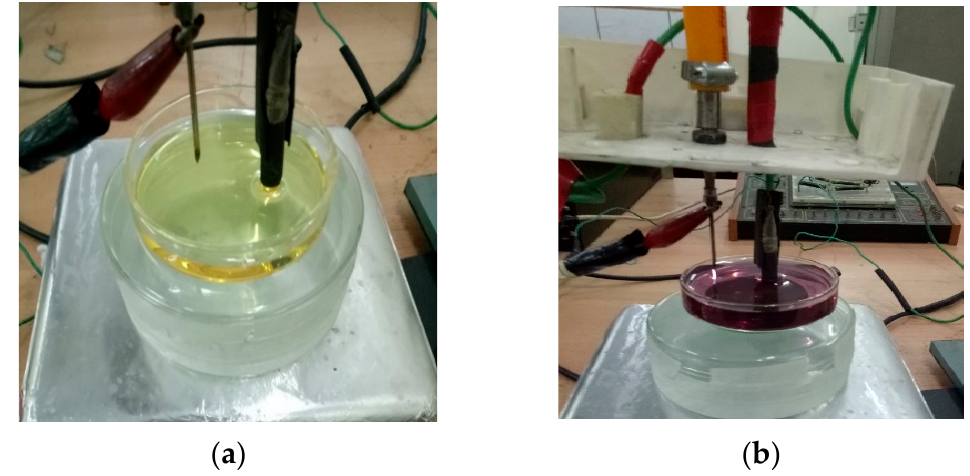
Figure 1. ( a ) 1.0 mM (HAuCl4·3H 2 O); 5 mM D-Fructose precursor; ( b ) Electrochemically reduced gold colloids after 20 min of microplasma